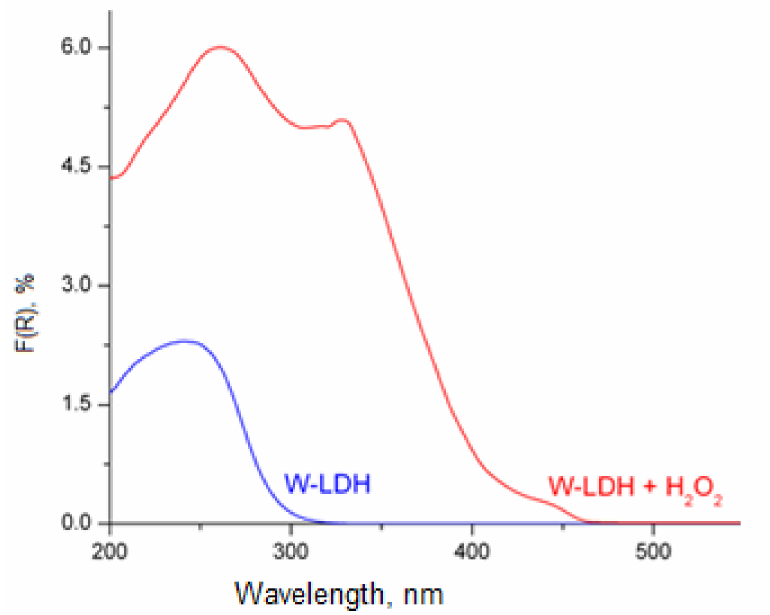
Figure 10. UV-vis -DR spectra of W-LDH before and during the oxidation reaction with H 2 O 2 . Reprinted with permission from ref. [111]. Copyright 2008